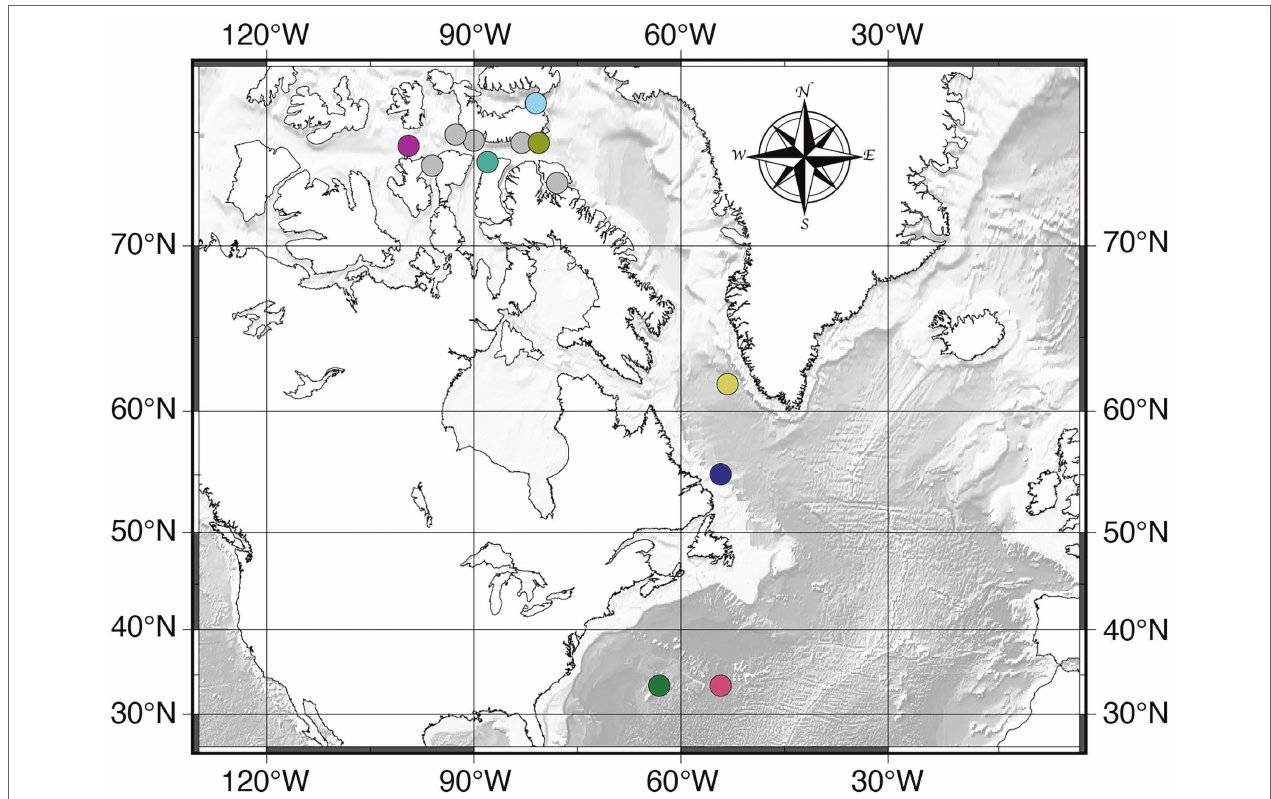
FIGURE 1 | Sampling locations for this study. Data presented in this manuscript includes all sample locations except for the data in Figures 2 , 5 , which only include the colored circles. The colors correspond to the same colors in Figures 2 , 5